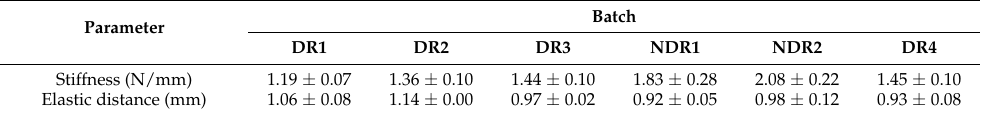
Figure 10. Load-deflection profiles of filament samples in tensile tests. Table 11. Summary of texturometer analysis.